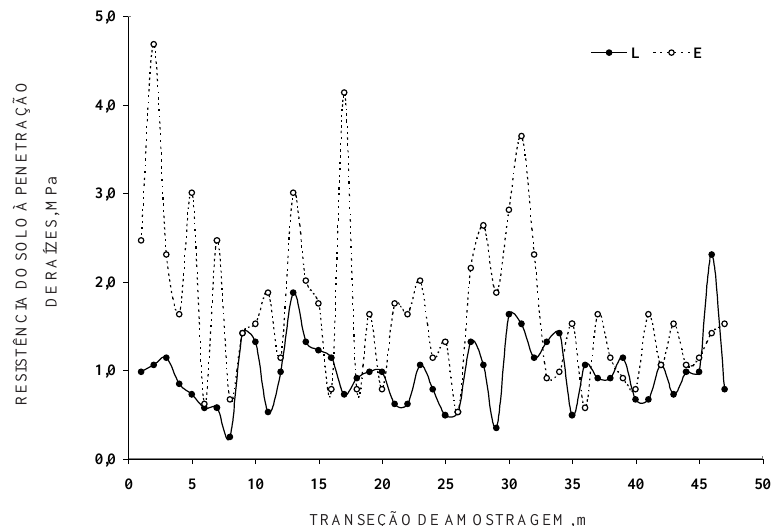
Figura 7. Resistência do solo à penetração de raízes na linha (L) e entrelinha (E) no sistema de preparo convencional ao longo de uma transeção perpendicular às linhas de cultivo em um Latossolo Roxo cultivado com milho, para umidade do solo equivalente à tensão de 0,70 MPa.